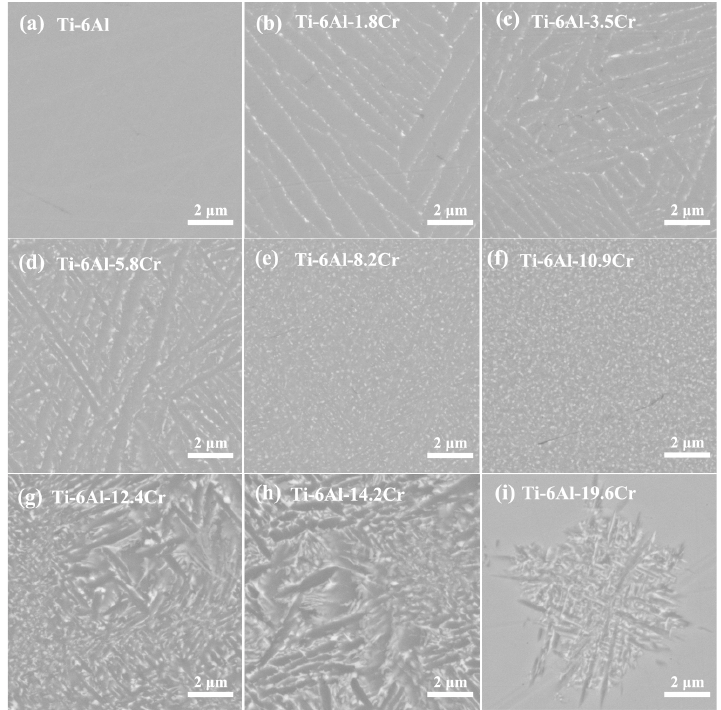
Figure 3. SEM, backscattered electron images of Ti-6Al-xCr alloy taken from the (Ti-6Al)–(Ti-6Al- 20Cr) diffusion couple, after aging at 600 °C.